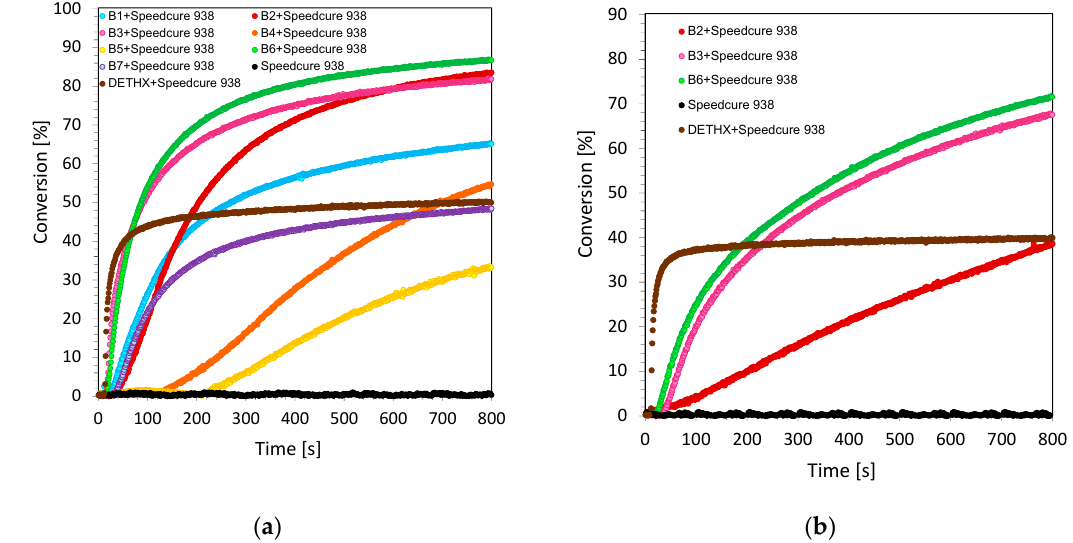
Figure 2. ( a ) Cationic photopolymerization profiles (epoxy function conversion vs. irradiation time) initiated by a bimolecular photoinitiating system based on Speedcure 938 (1% wt.) and 2-amino-4-methyl-6-(4-phenylphenyl)benzene-1,3-dicarbonitrile derivatives (0.1% wt.) for series 1 ( a ) under irradiation at 365 nm; ( b ) under irradiation at 405 nm.